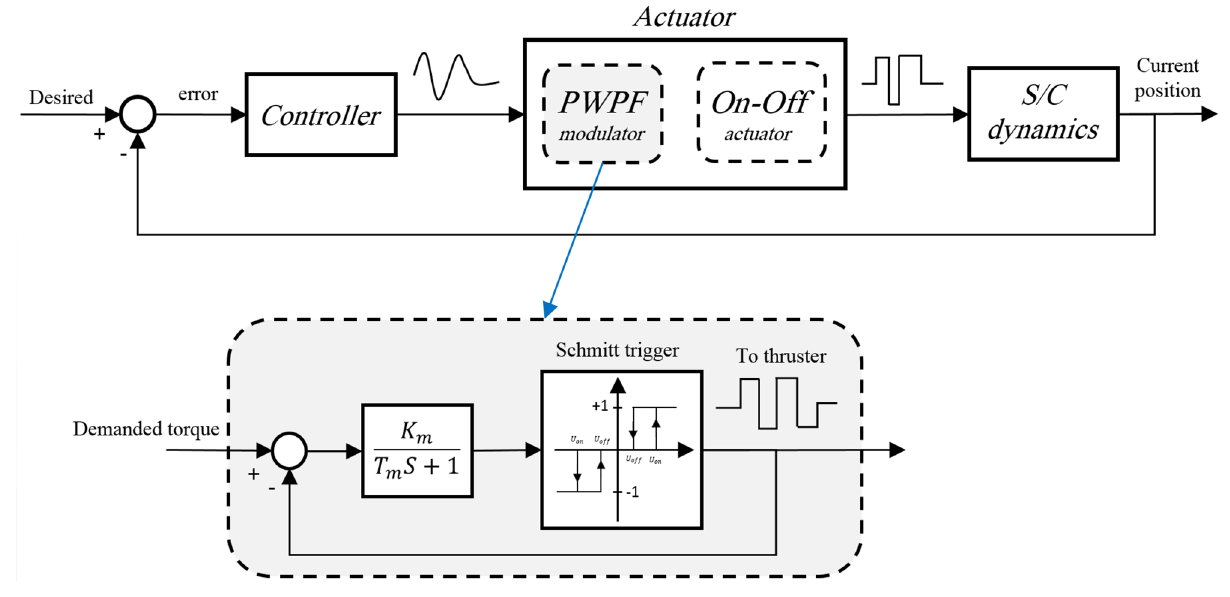
Figure 7. Block diagram of the PWPF